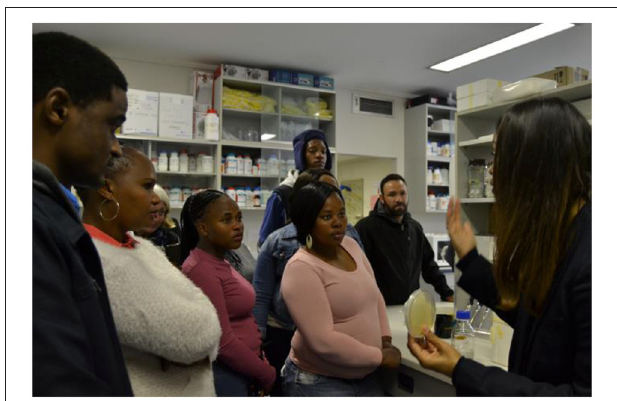
FIGURE 3 | The head of the Water Resource Laboratory, Stellenbosch University, demonstrates the use of agar petri dishes to Enkanini participants as part of knowledge exchange activities.